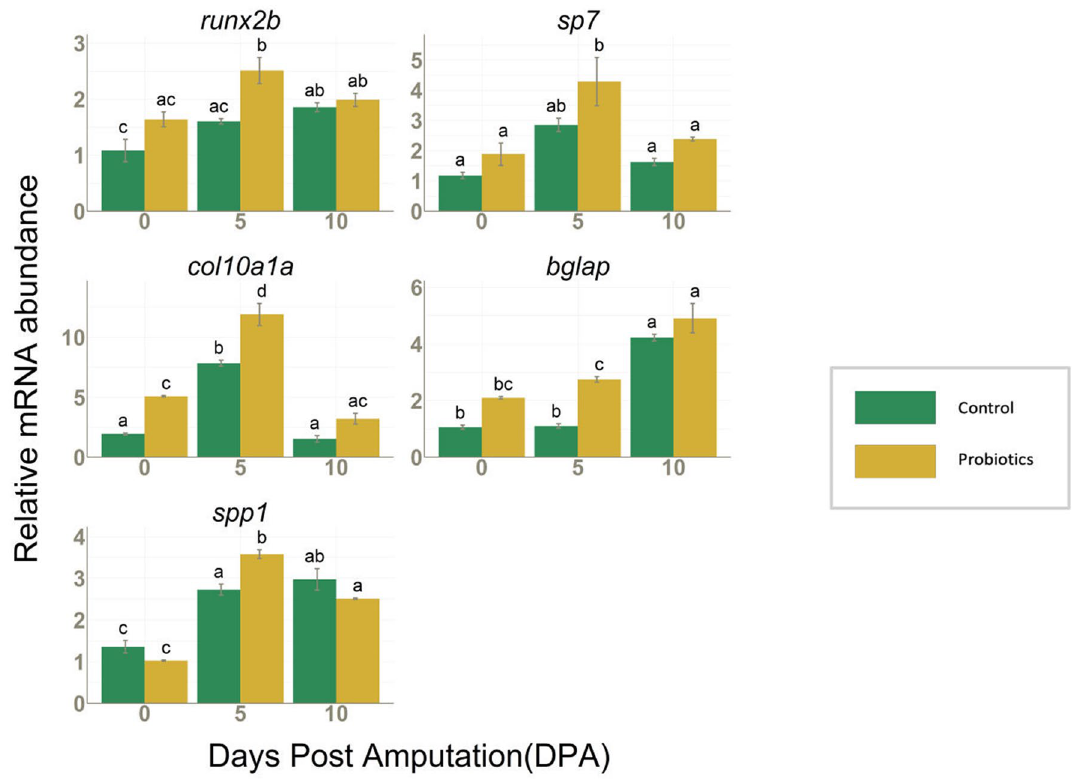
Figure 3. runx2b, sp7, col10a1a, bglap and spp1 mRNA values normalized against rplp0 and rpl13 in fins collected from C (n = 3) and P (n = 3) groups at 0, 5 and 10 DPA. Data are presented as mean ± S.D. Different letters over the histograms indicate statistically significant difference among groups. Two-way ANOVA and Tukey’s multiple comparison test are used, and statistical significance was set at p <